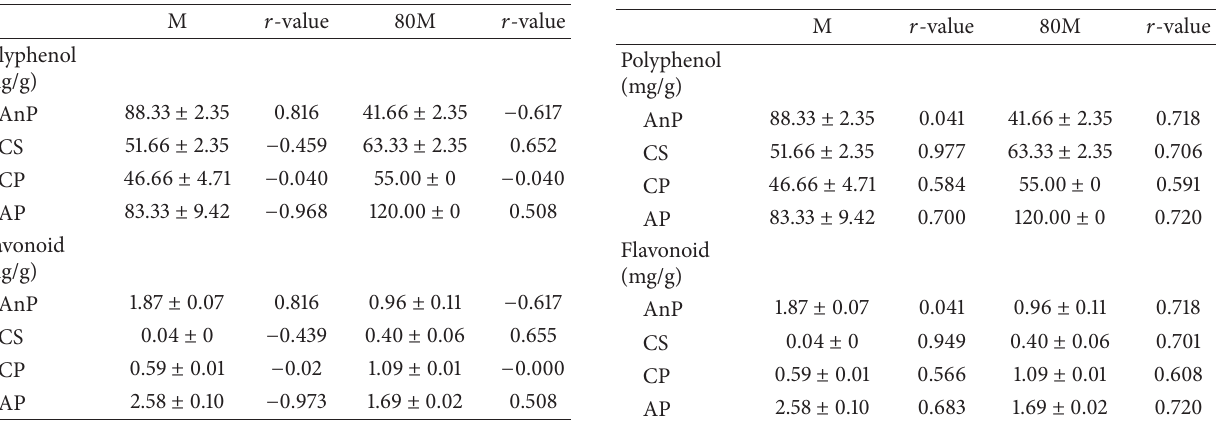
Table 1: Correlation between the antioxidant activity of plant extracts against cholesterol oxidation and the content of polyphenol and flavonoid in the extracts.